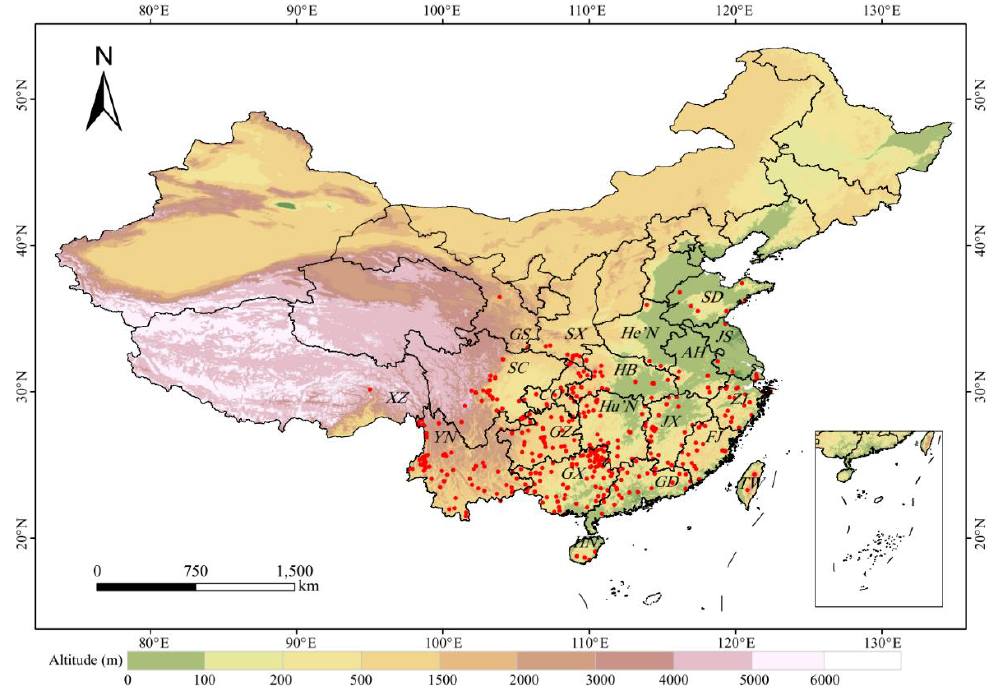
Figure 1. Distribution of tea specimen occurrences in China. The red dots are the occurrence location; SD: Shandong, He’N: